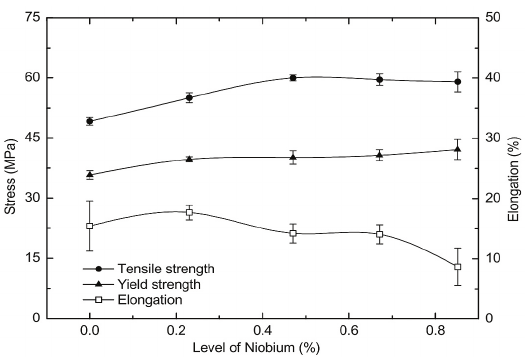
Figure 4. Yield strength, tensile strength and elongation for NCIs with various Niobium